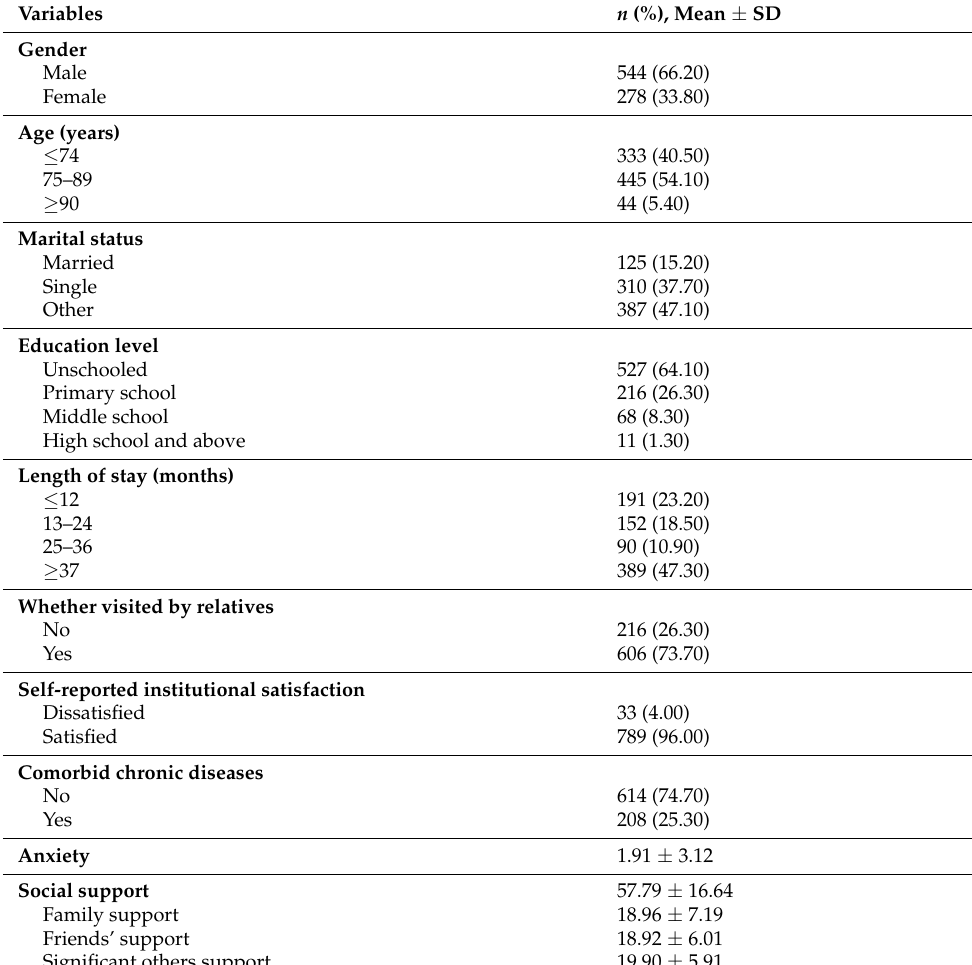
Table 1. Descriptive results of the participants ( n =